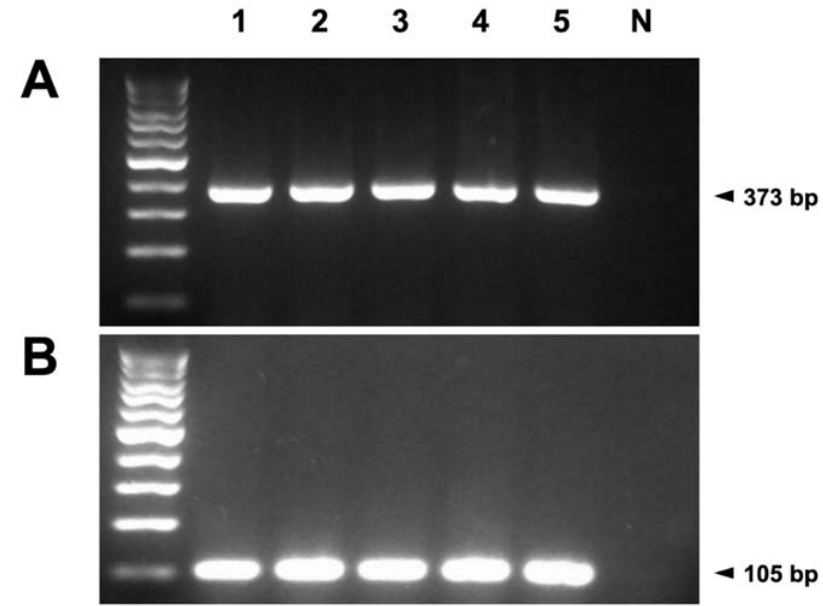
Figure 1. ( A ) mRNA of TRPM7 was detected in five (1–5) canine mammary gland tissues by reverse transcription ‐ polymerase chain reaction (RT ‐ PCR). The amplified products of TRPM7 (373 bp) were